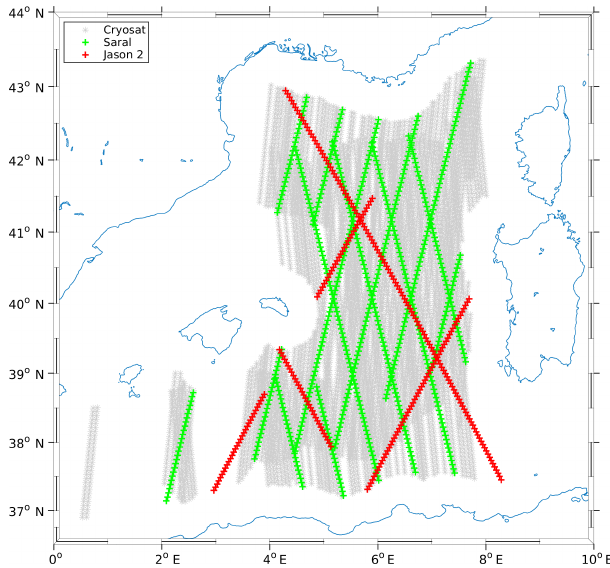
Figure 1. Distribution of altimeter tracks in the NW Mediterranean Sea showing the different missions: the 10-day repeat Jason-2 mis- sion in red, 35-day repeat SARAL/AltiKa in green, and the 380-day repeat CryoSat-2 in grey. Only sections greater than 200km are in- cluded in the spectral analysis, and only data more than 50km from the coast are analysed to remove the increased errors in the coastal zone. The distance from the coast is calculated using the Stumpf database